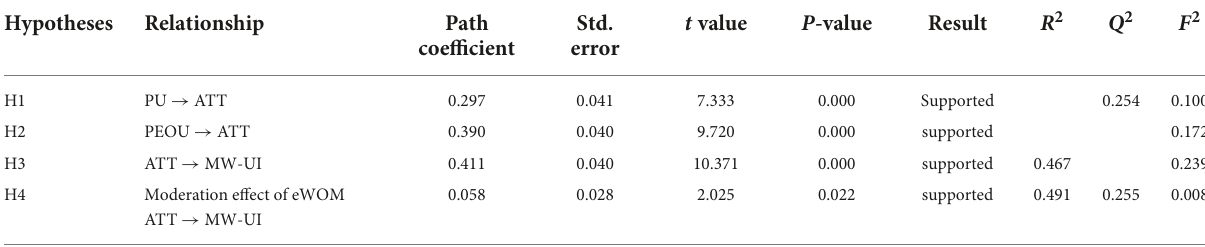
TABLE 5 Hypotheses